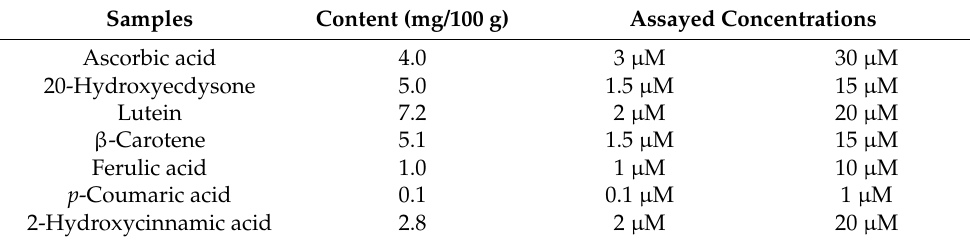
Table 1. Concentration of pure phytochemicals tested in comet